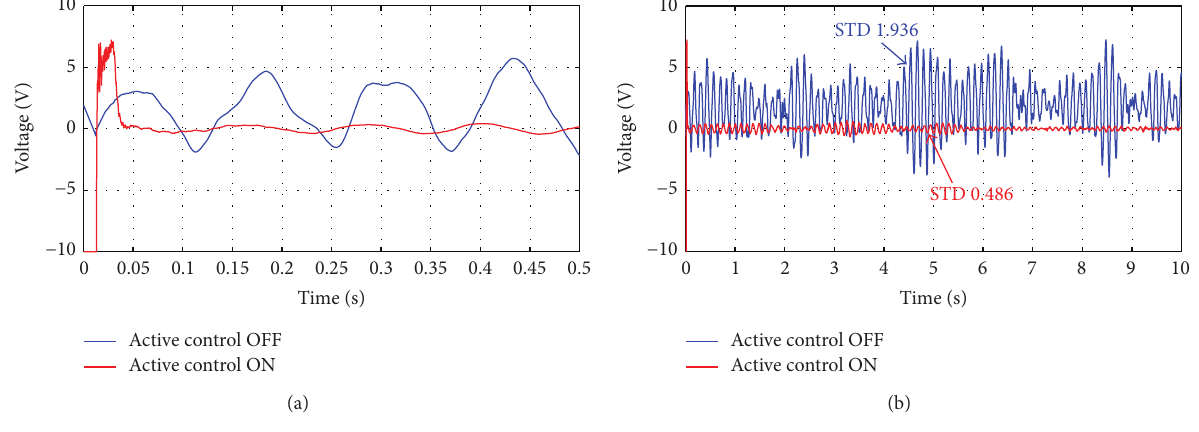
Figure 11: Cantilever system response during BP NN controller testing.